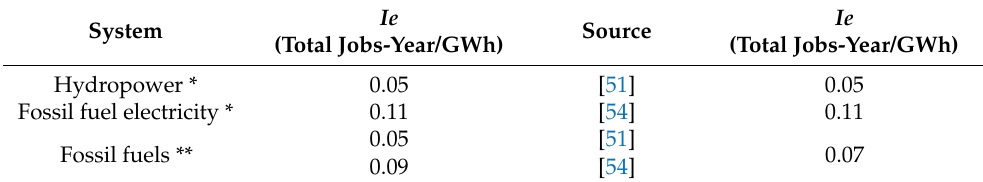
Table 26. Use of traditional energy sources.